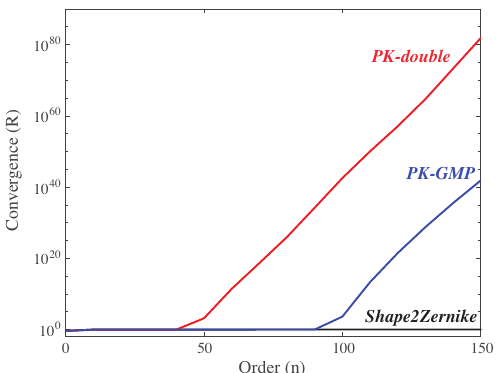
Figure 5. Numerical stability of the computation of Zernike moments. We plot the ratio of the sum of the norms of the Zernike moments to the value of c 0 Equation (38)). We use three different programs, PK-double that implements the PK algorithm which is a computation of the Zernike moments from the geometric moments of the shape using double precision 0, PK-GMP that implements the same calculation using full arbitrary precision arithmetic, and Shape2Zernike based on Algorithm 3 of this